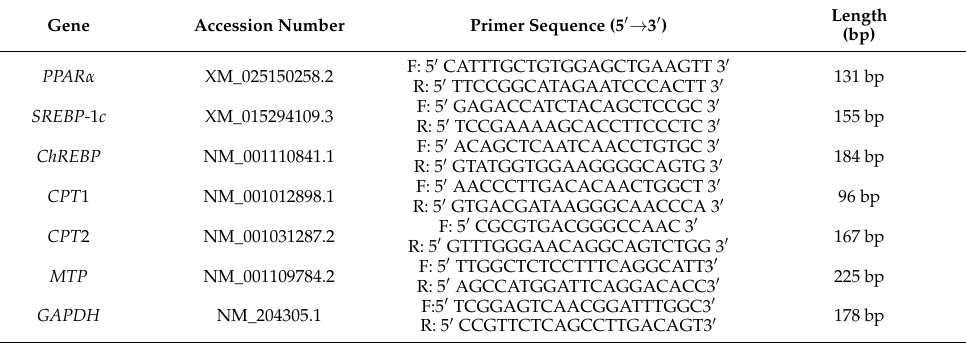
Table 1. Primer sequences and amplicon sizes for target lipid metabolism-related